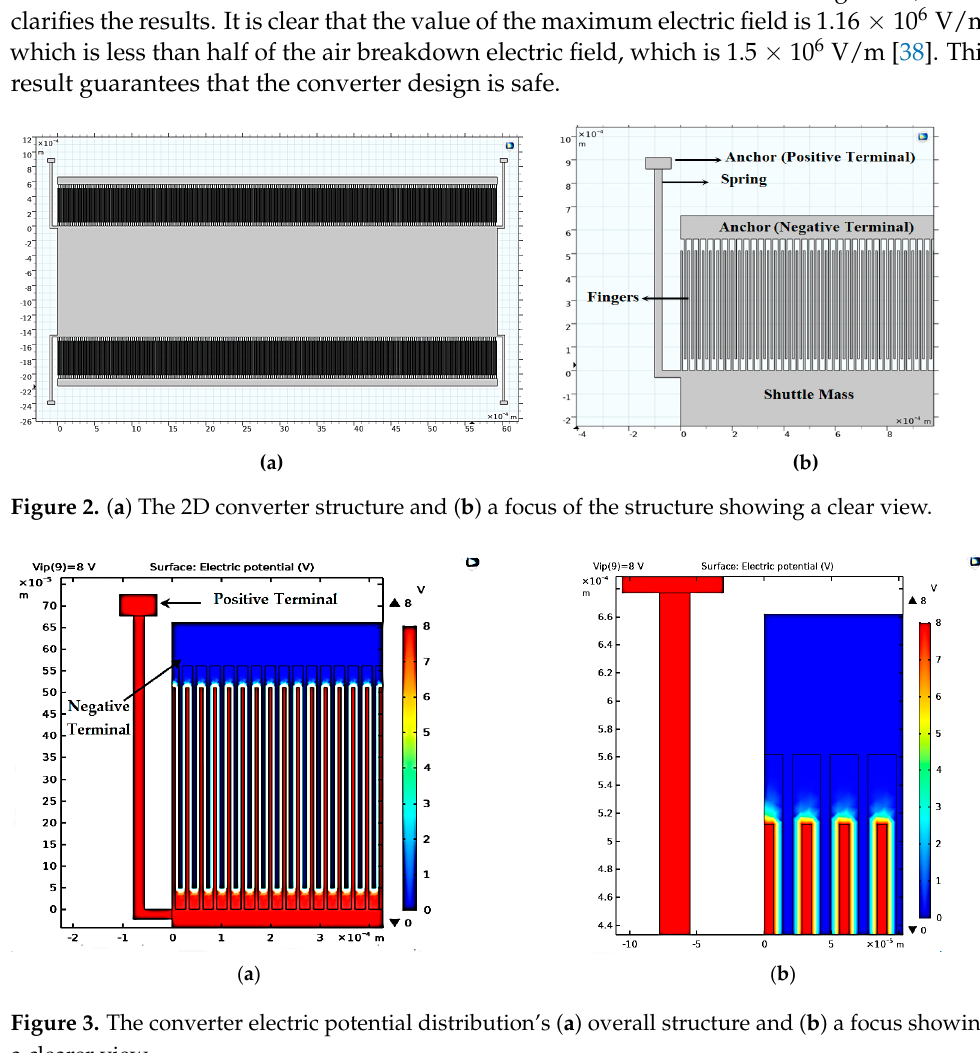
( a ) ( b ) Figure 4. The electric field distribution’s ( a ) overall structure and ( b ) a focus showing a clearer view. 3.2. The Converter Displacement due to the Input Vibration Signal In this subsection, the input vibration signal of the vibration source is applied to the converter. Thus, the maximum displacement of the converter can be measured. As shown in Figure 5a, the nominal gap between converter fingers at rest position ( d nom ), at which the minimum capacitance of the converter occurs, is 7 µm. Additionally, the minimum distance ( d min ) at which the maximum capacitance of the converter occurs is 0.25 µm. Thus, the maximum displacement of the converter fingers must be d nom – d min = 6.75 µm. Figure 5b shows the simulation results of the converter’s maximum displace- ment. It is equal to 6.75 µm, which quantitatively verifies the analytically calculated value based on Figure 5a. This value satisfies the proper operation of the converter.